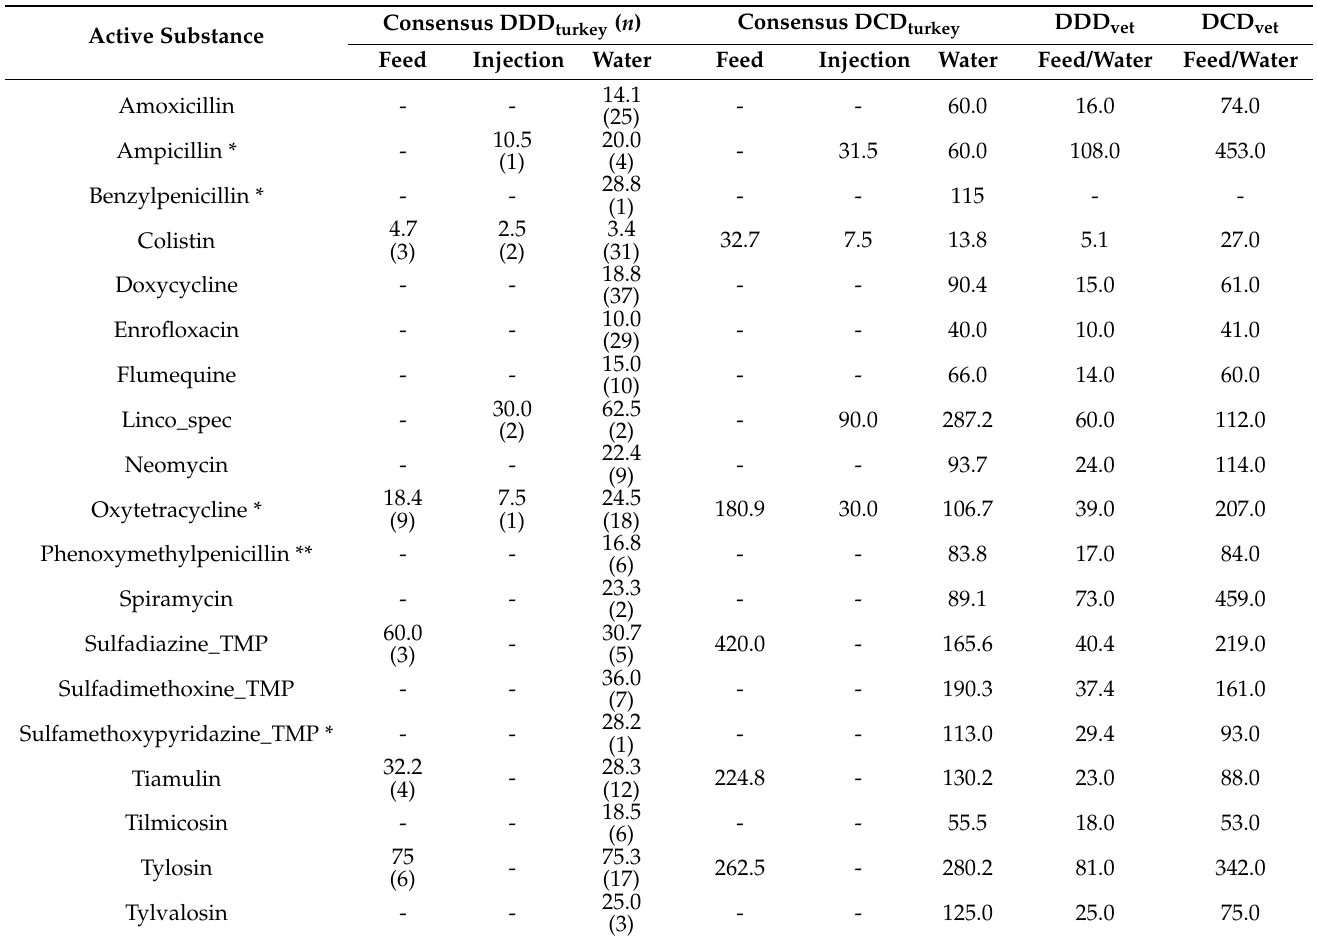
Table 1. Mean DDD turkey and DCD turkey values (consensus DDD turkey and consensus DCD turkey ) for each category with a unique combination of active substance and administration route, combined with the corresponding DDD vet and DCD vet values for broilers from the European Surveillance of Veterinary Antimicrobial Consumption (ESVAC), when available [18]. Active